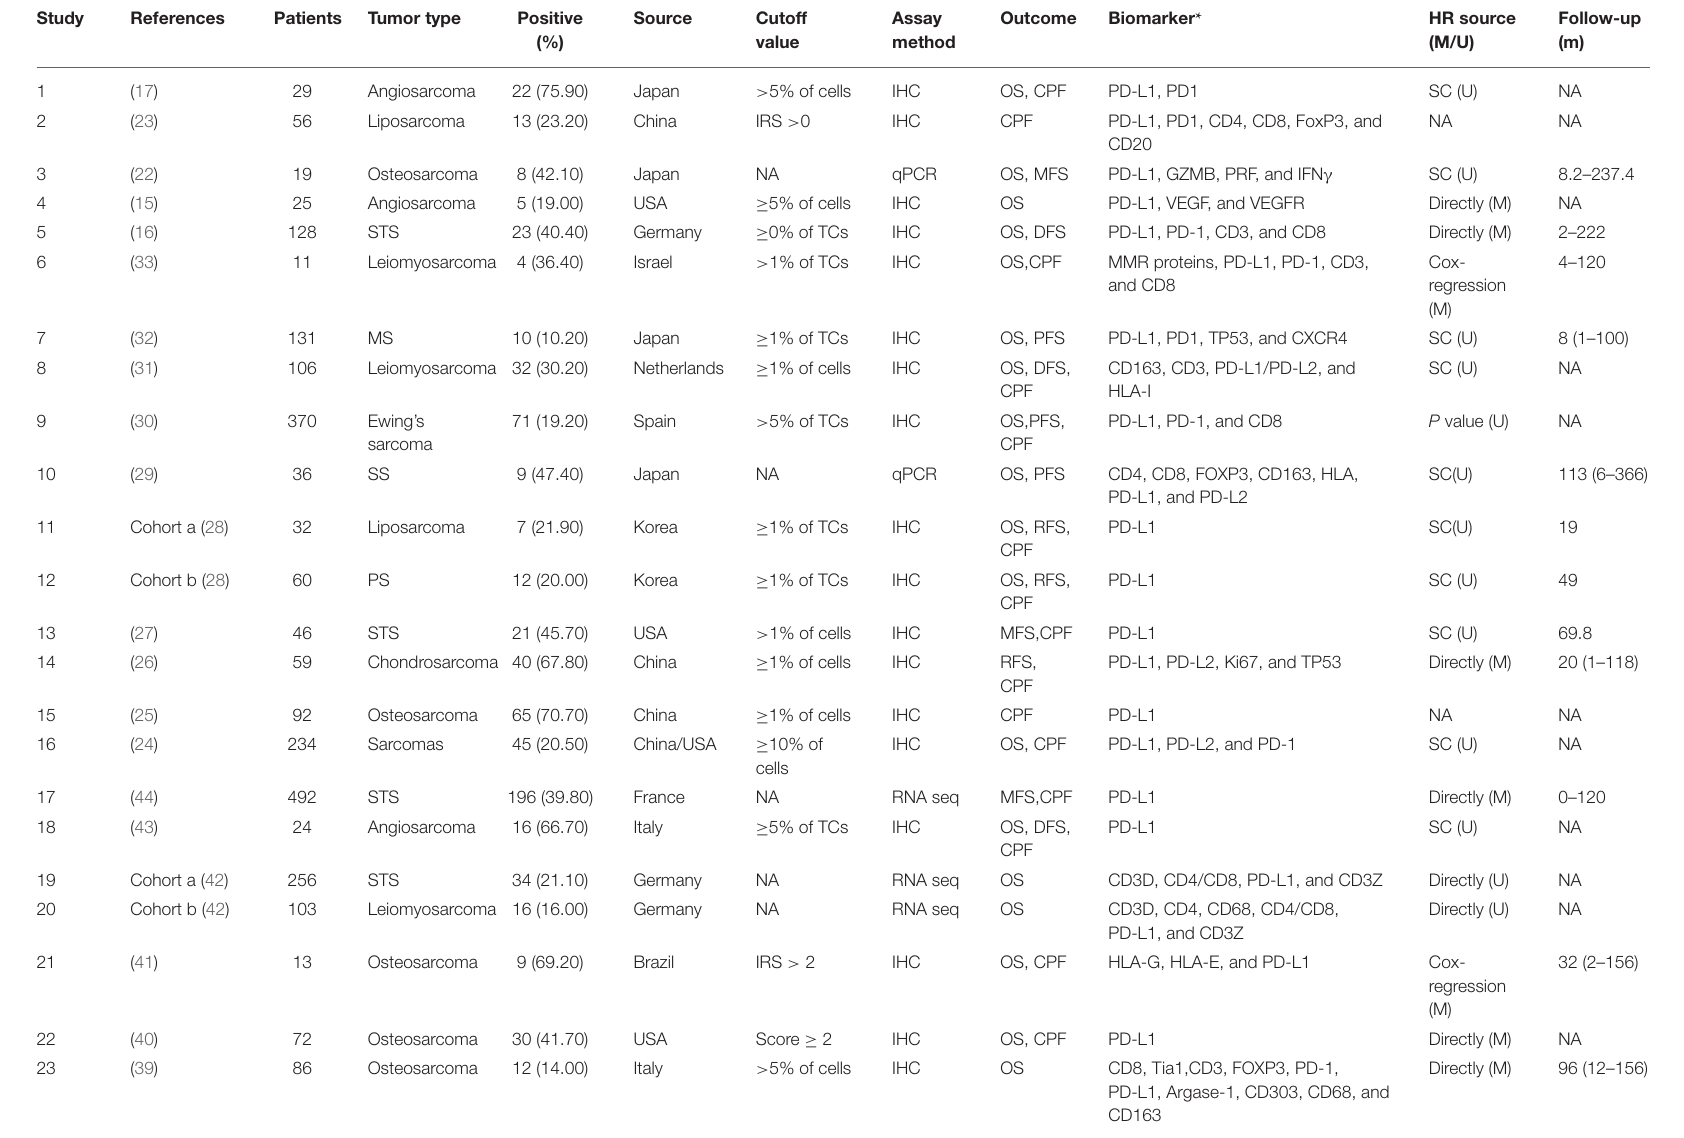
TABLE 1 | Characteristics of the included